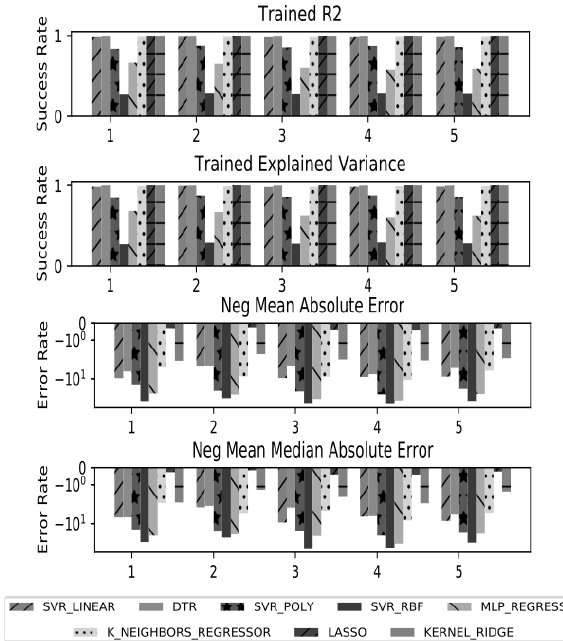
Figure 5. Error rate of Machine learning models applied for survival time prediction. Where on the x axis are the groups and on the y axis are shown accuracy and error rate estimate measures. Table 1. Aggregated results of cross-validation.